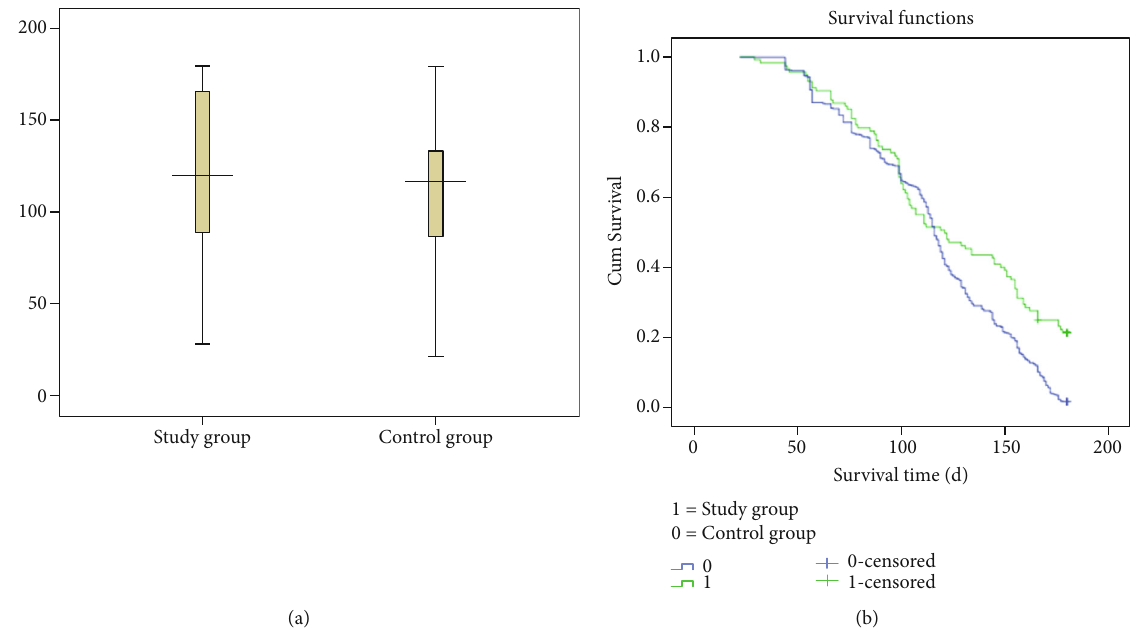
Figure 2: The box-plot distribution and comparative analysis of the survival time between patients with drainage treatment from study group ( n = 113 ) and patients with drainage treatment from control group ( n = 496 ) was di ff erent ( z = − 2 : 230 , P value = 0.026). The Kaplan-Meier method was used to estimate survival rate and compare survival curve of patients with drainage treatment from two groups: the curve of control group was below, and the curve of study group was above, which showed that metformin use can improve survival rate. Log-rank tests and Breslow were performed to check; P value was less than 0.05.